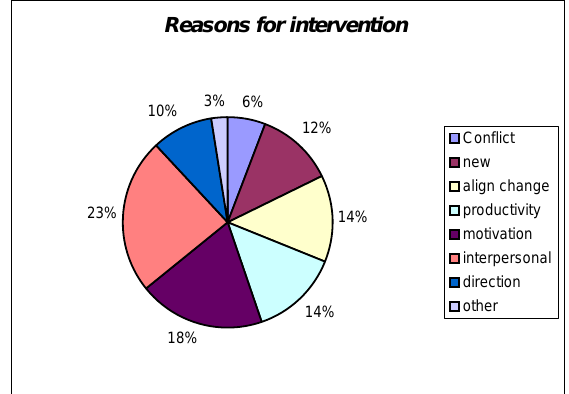
Figure 4: Nature of assessment Type of activity used